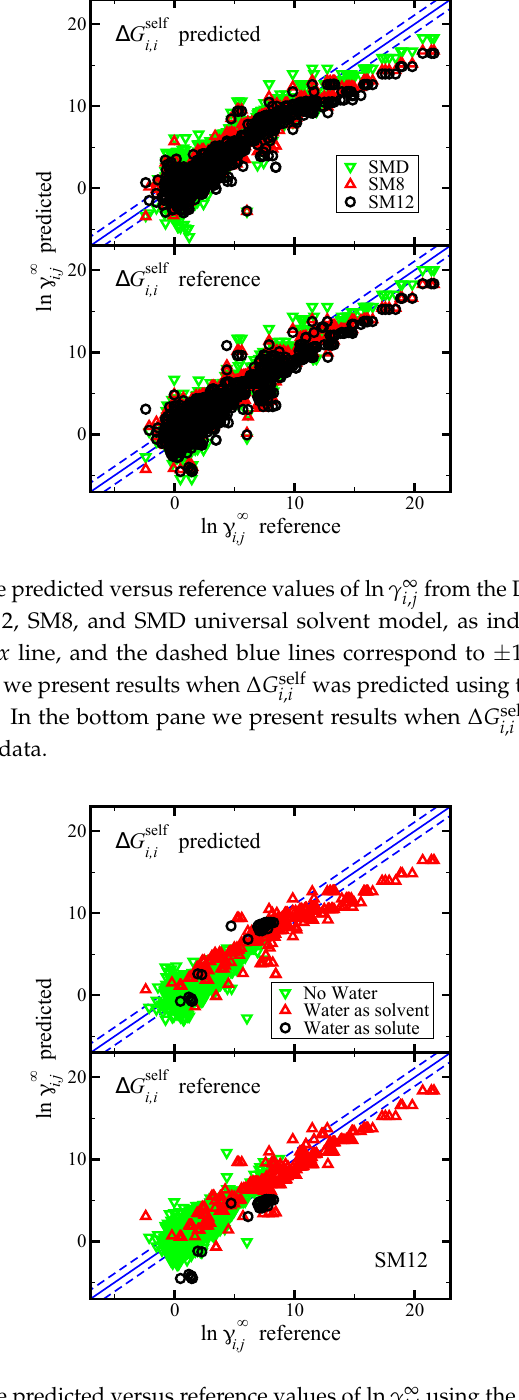
Figure 7. Parity plot of the predicted versus reference values of ln γ ∞ using the SM12 universal solvent i , j model for the case where water was the solvent, water was the solute, and where water was neither the solvent or solute, as indicated. The blue lines corresponds to the y = x line, and the dashed blue lines correspond to ± 1.1 and are drawn as a reference. The reference values are from DECHEMA. In the top pane we present results when ∆ G self was predicted using the SM12 universal solvent model. In the i , i bottom pane we present results when ∆ G self was computed using reference vapor pressure i , i